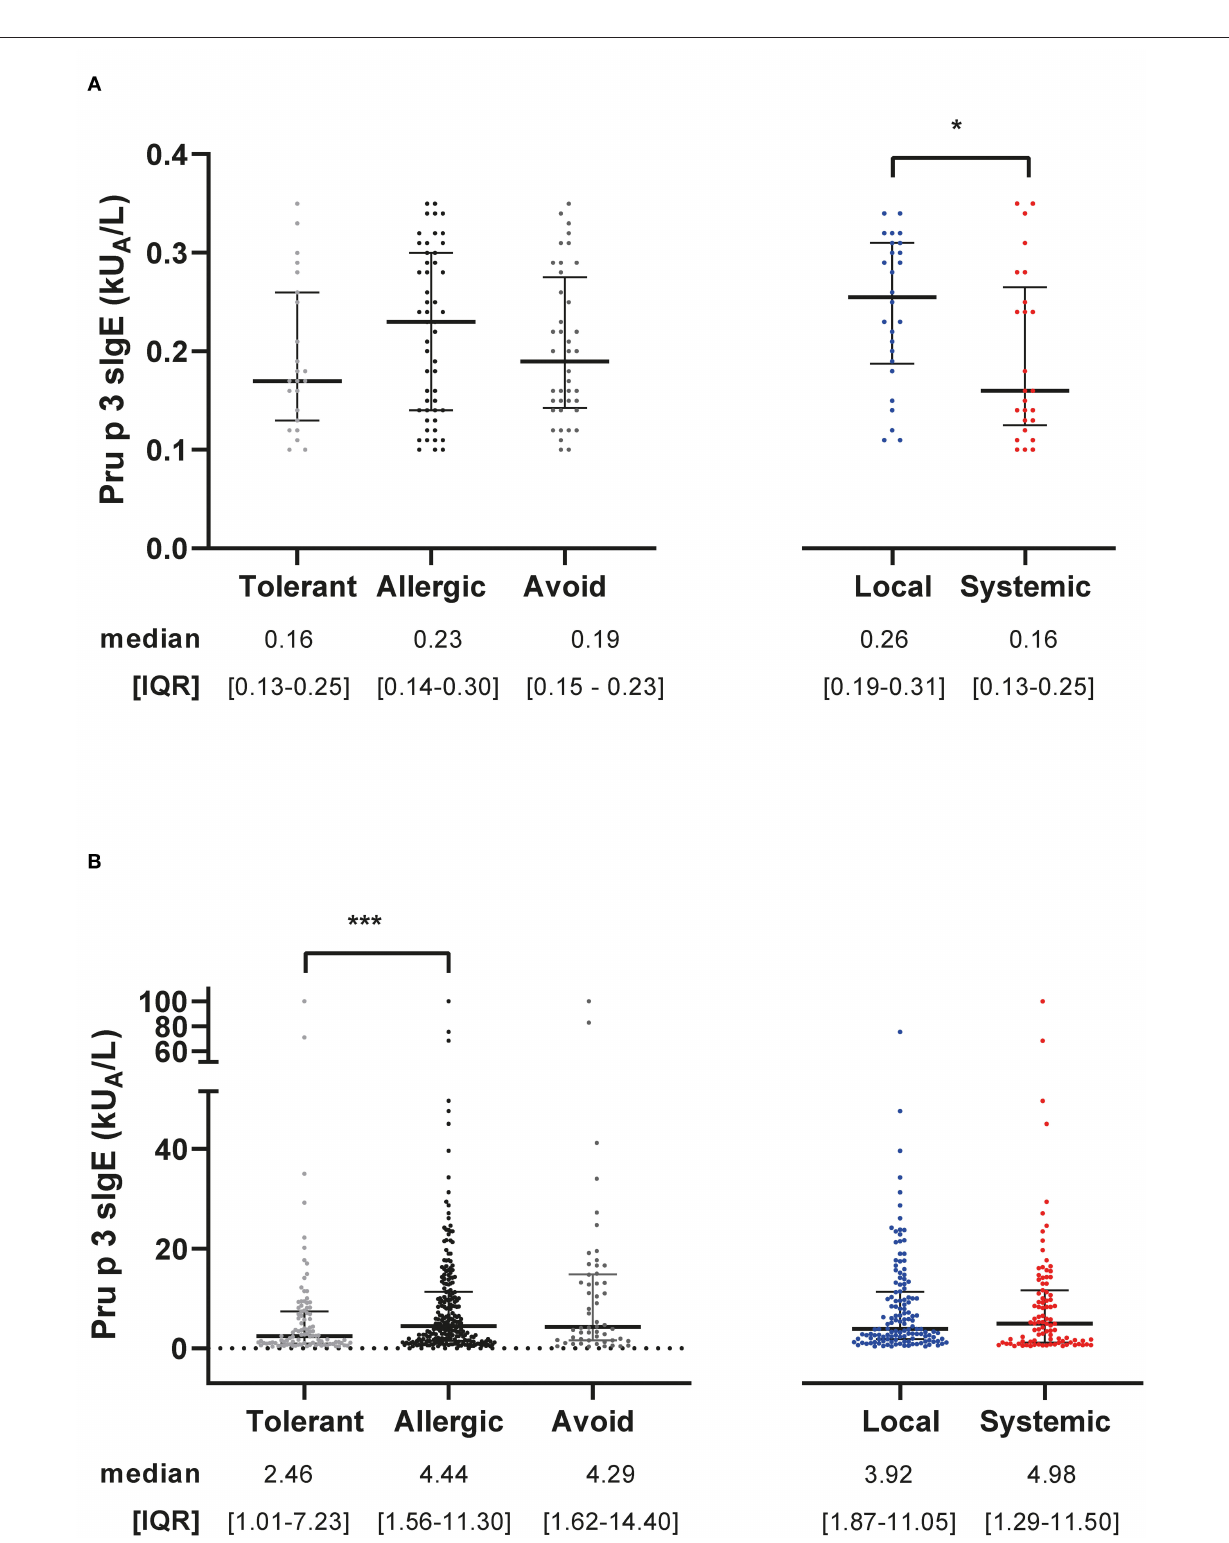
Frontiers in Allergy |